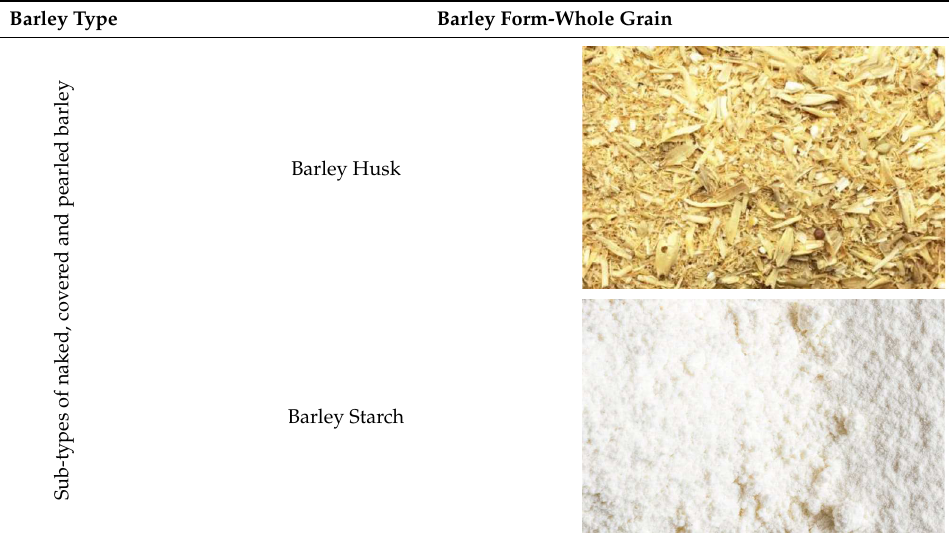
Table 2. Chemical composition of covered and naked barley grain